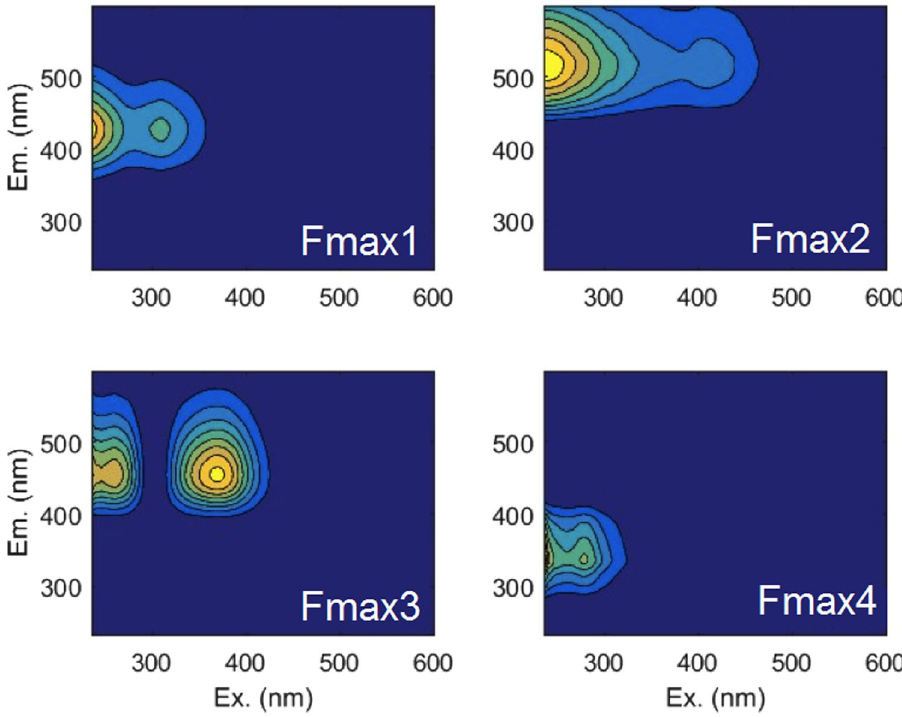
Figure 2. EEM - PARAFAC statistical components Fmax1–4 of fluorescence observed in all